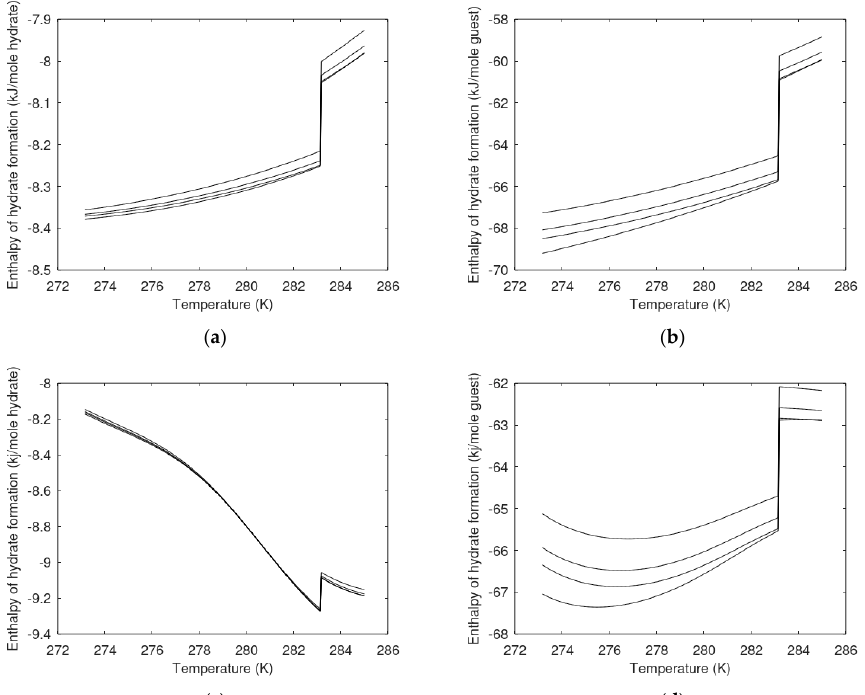
Figure 7. ( a ) Enthalpy of hydrate formation per mole hydrate as function of temperature and mole-fraction ethanol in water for pure CO 2 hydrate. The lowest curve is for no ethanol in water, then 0.015 mole-fraction ethanol in water, then 0.02 mole-fraction ethanol in water, and upper curve 0.03 mole-fraction ethanol in water. ( b ) Enthalpy of hydrate for- mation per mole guest in hydrate as function of temperature and mole-fraction ethanol in water for pure CO 2 hydrate. The lowest curve is for no ethanol in water, then 0.015 mole-fraction ethanol in water, then 0.02 mole-fraction ethanol in water, and upper curve 0.03 mole-fraction ethanol in water. ( c ) Enthalpy of hydrate formation per mole hydrate as function of temperature and mole-fraction ethanol in water for hydrate formed from 20 mole percent N 2 in CO 2 . The lowest curve is for no ethanol in water, then 0.015 mole-fraction ethanol in water, then 0.02 mole-fraction ethanol in water, and upper curve 0.03 mole-fraction ethanol in water. ( d ) Enthalpy of hydrate formation per mole guest in hydrate as function of temperature and mole-fraction ethanol in water for hydrate formed from 20 mole percent N 2 in CO 2 . The lowest curve is for no ethanol in water, then 0.015 mole-fraction ethanol in water, then 0.02 mole-fraction ethanol in water, and upper curve 0.03 mole-fraction ethanol in water.